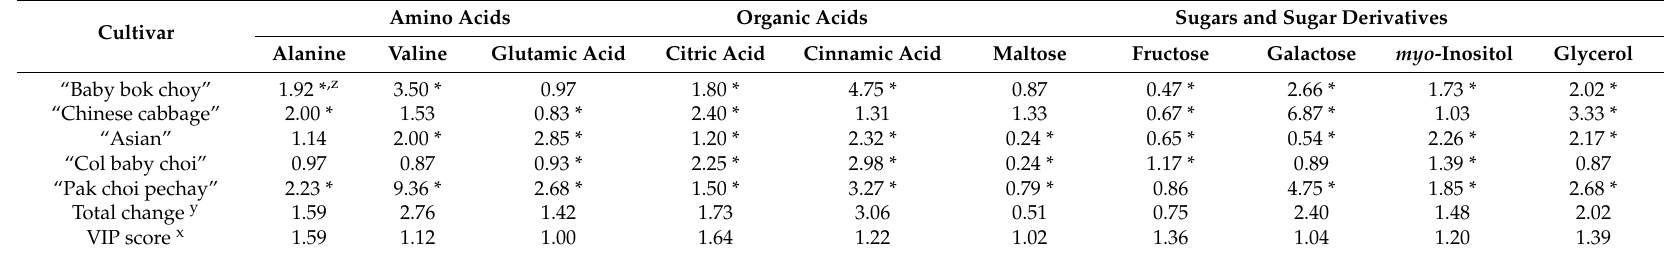
Table 2. Fold change of primary metabolites in MeJA-treated pak choi compared to control pak